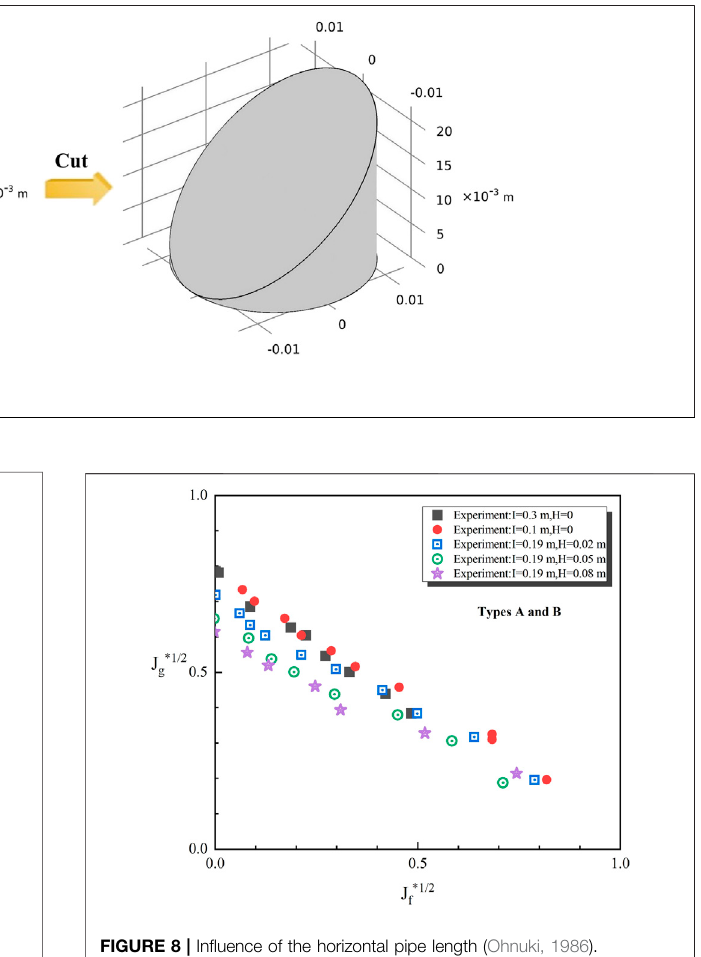
FIGURE 7 | Coordinate chart for area calculation of sharp inclined pipe. FIGURE 8 | In fl uence of the horizontal pipe length (Ohnuki,